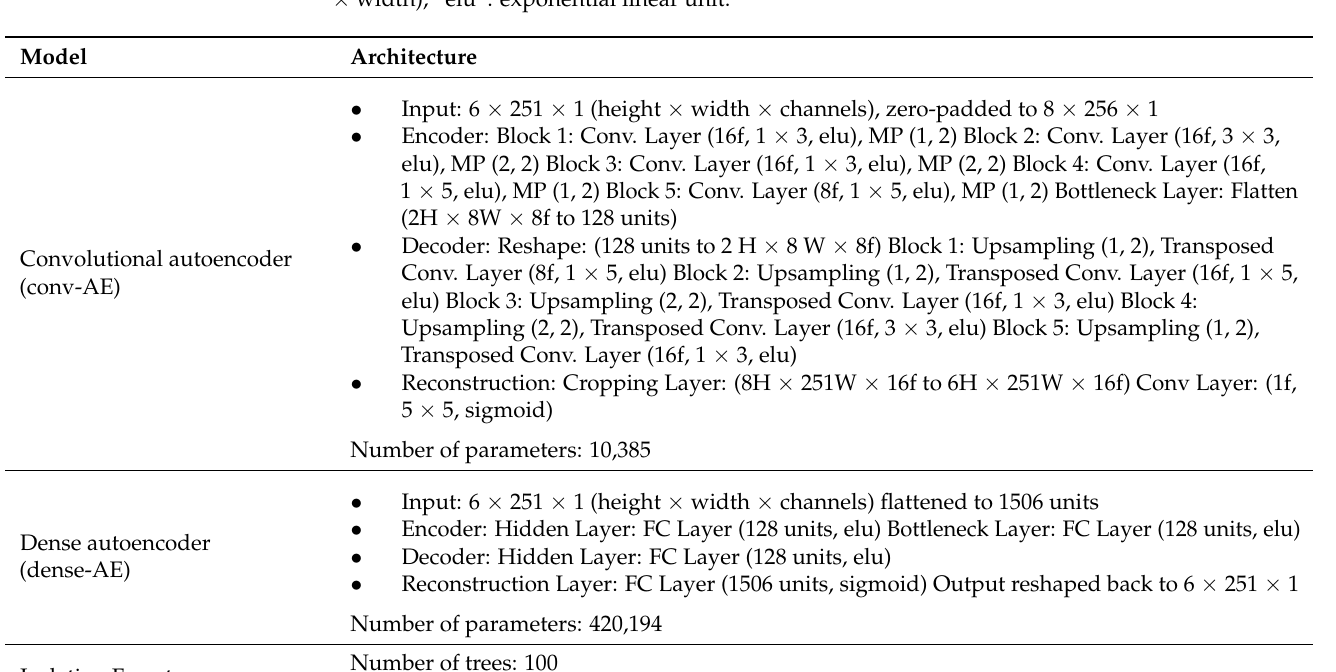
Table 3. Specifications of the models used in our work. The abbreviations are “FC Layer”: fully- connected layer (number of units, activation function); “Conv. Layer”: convolutional layer (number of feature maps, kernel size in height x width, activation function); “MP”: max-pooling layer (height × width); “elu”: exponential linear